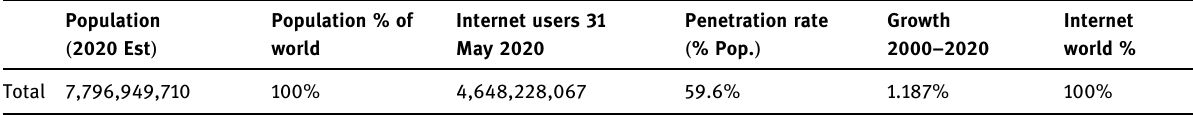
Table 1: World internet usage and population statistics